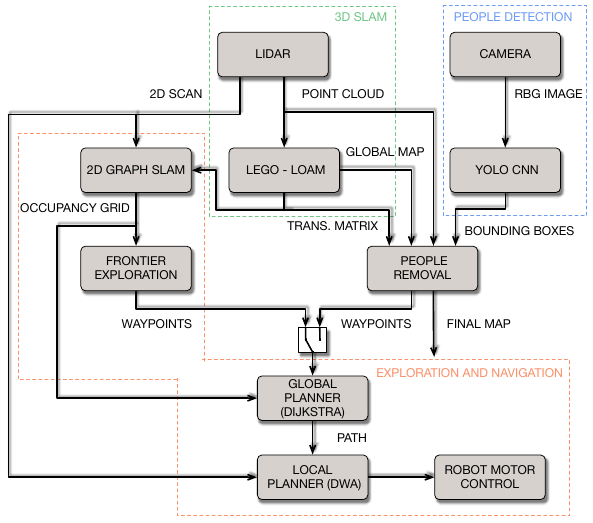
Figure 1. Flowchart of the proposed